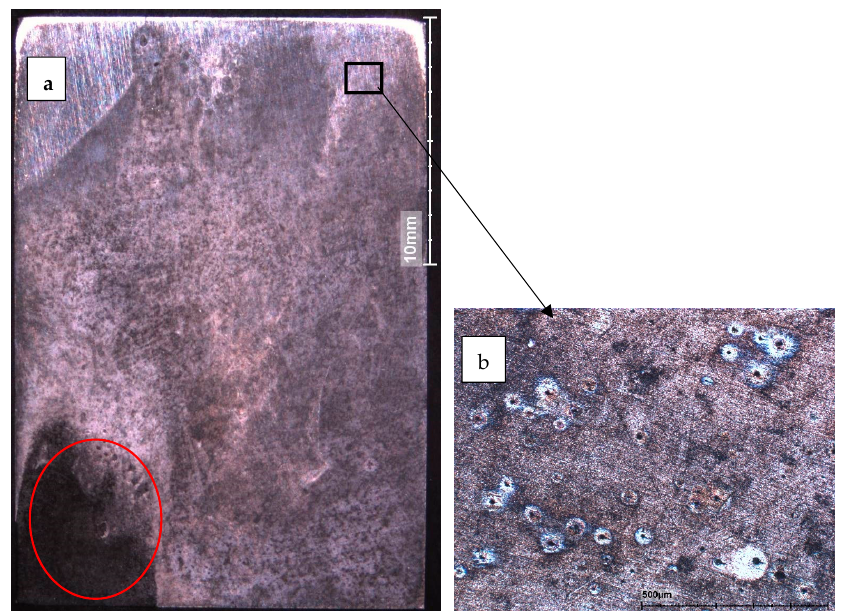
Figure 11. An image for the sample S15 exposed to seawater for 7 days (after cleaning the surface). Local corrosion attack was found near the bottom-left corner ( a ) and small pits near the upper-right corner zoomed in the image ( b ).